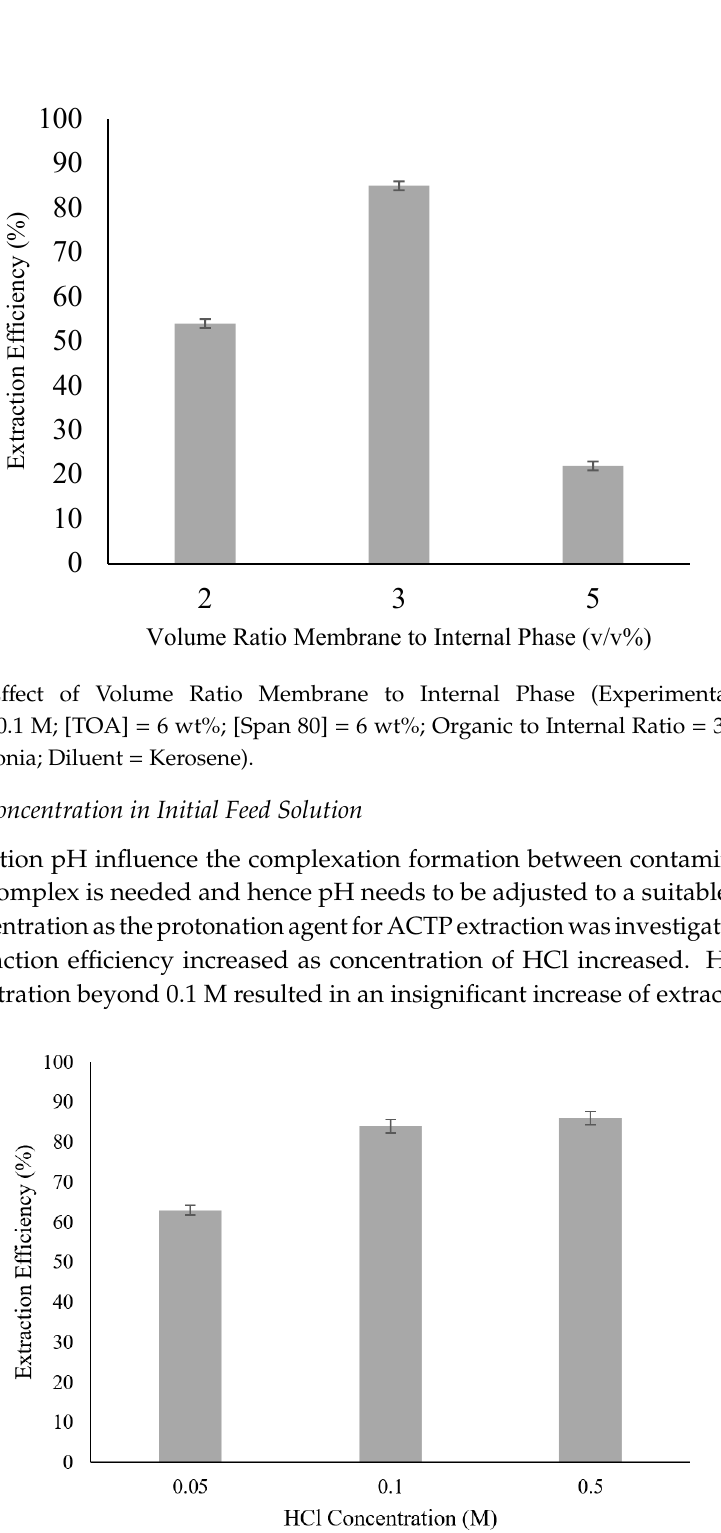
Figure 5. E ff ect of HCl concentration (Experimental condition: [Ammonia] = 0.1 M; [TOA] = 6 wt%; [Span 80] = 6 wt%; Volume Ratio = 3:1; Stripping Agent = Ammonia; Diluent = Kerosene). Lowest extraction e ffi ciency of 63% was found at HCl concentration of 0.05 M. Lower concentration of protonation agent caused lower tendency for ACTP-TOA complex to form and hence limiting the mass transfer process. Further increase in HCl concentration of 0.5 M from 0.1 M did not significantly increase extraction e ffi ciency; both at 86 and 84% respectively. In addition, it increases the